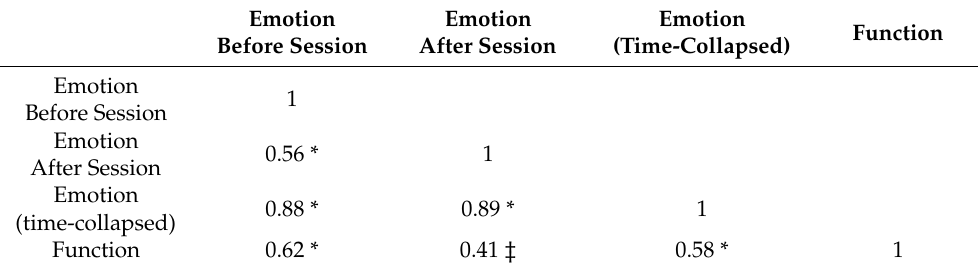
Table 2. Bivariate correlation among dependent measurements.